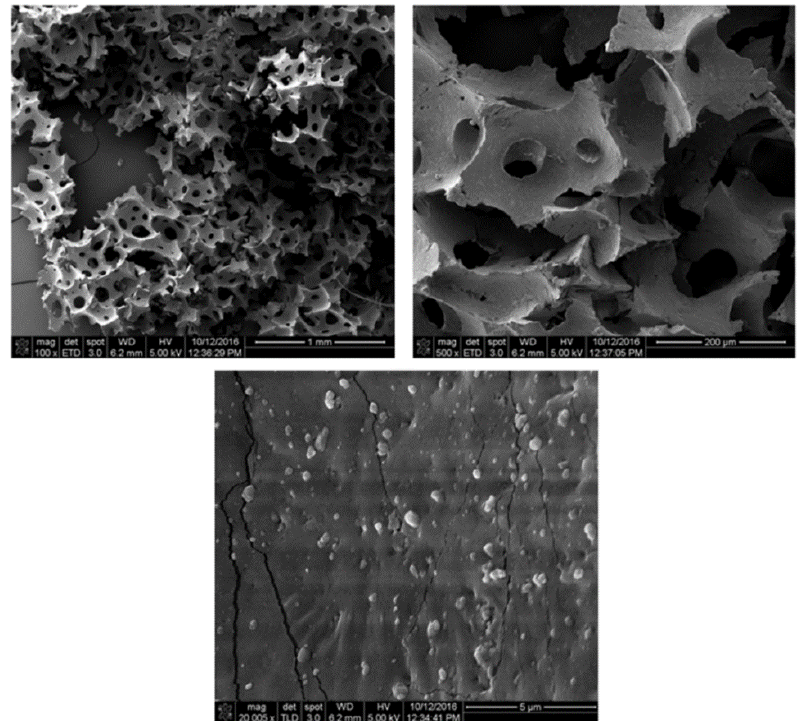
Figure 1. Low and high magnification SEM images of latex.